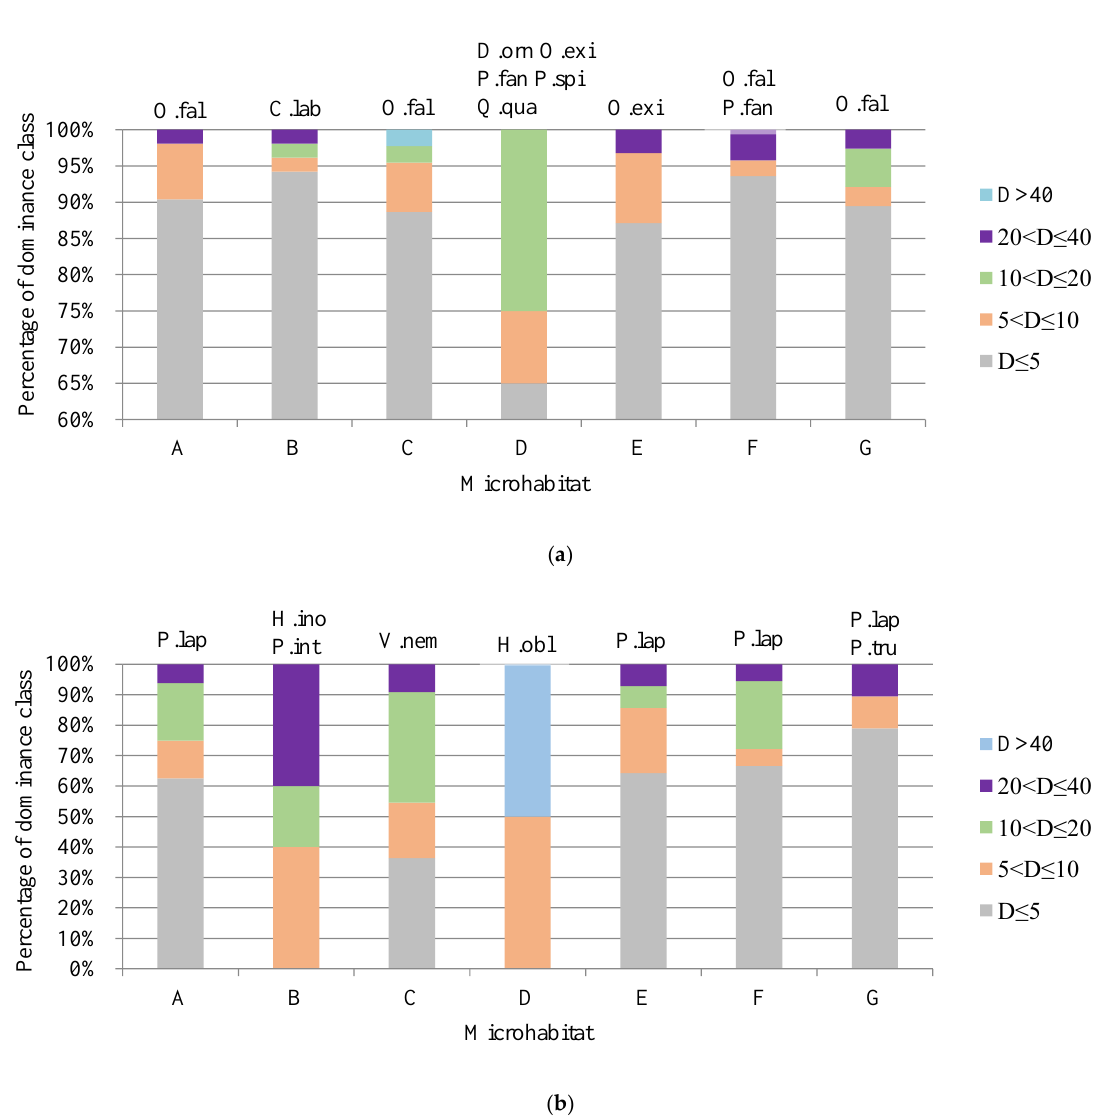
Figure 5. Dominance of Oribatida ( a ) and Mesostigmata ( b ) species in different microhabitats of broadleaf forest in Eastern Norway: A—moss on ground, B—lichens on tree twigs lying on ground, C—moss on tree trunks at ground level, D—moss on tree trunks 1.5 m above ground, E—moss on decaying stump, F—moss on decaying log, G—decaying wood from trees; most abundant species: C.lab— C. labyrinthicus , D.orn— D. ornata , O.fal— O. falcata , O.exi— O. exilis , P.fan— P. fanzagoi